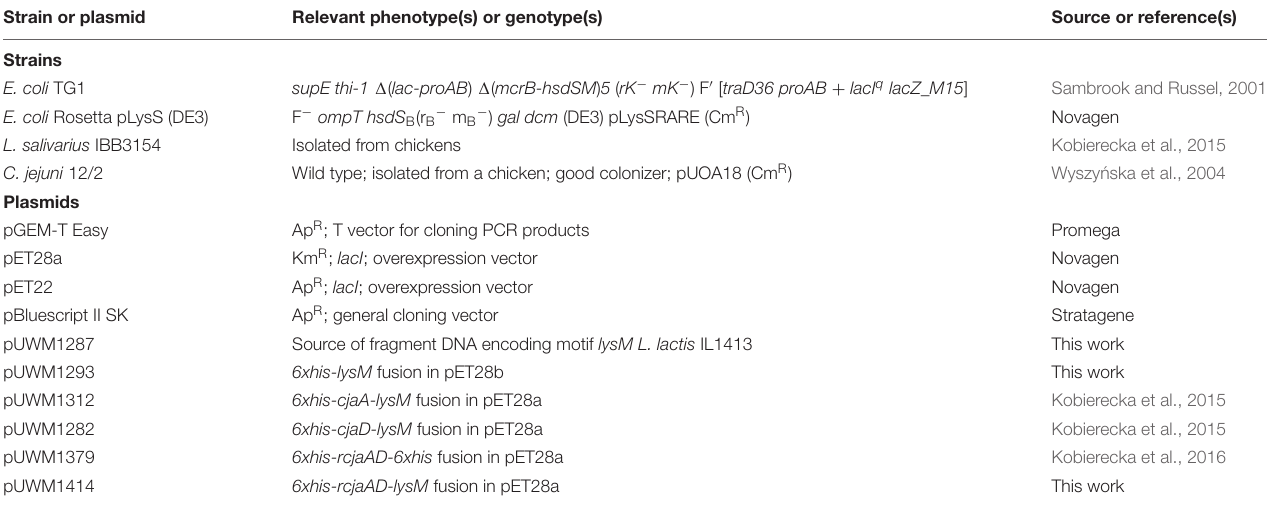
TABLE 1 | Bacterial strains and plasmids used in this study. Strain or plasmid Relevant phenotype(s) or